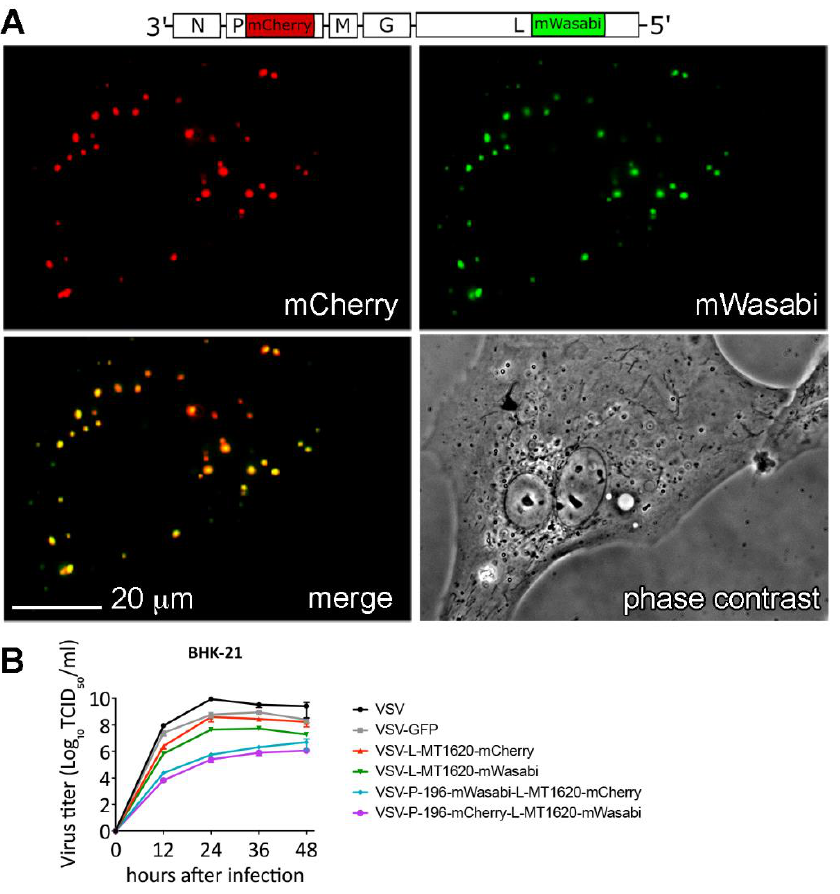
Figure 6. Attenuated double P- and L-insertion viruses display co-localizing fluorescent signals: ( A ) Assessment of putative P- and L-protein interaction in a representative micrograph of BHK-21 cells infected with VSV-P-mCherry-L-mWasabi at MOI of 10 at 10 h post infection. ( B ) Viral replication kinetics of parental VSV, VSV-GFP, VSV-L-MT1620-mCherry, VSV-L-MT1620-mWasabi, VSV-P-mWasabi-L-mCherry, and VSV-P-mCherry-L-mWasabi compared in BHK-21 at 37 °C in a multistep replication kinetics (MOI 0.1) at time points 12, 24, 36, and 48 h after infection. Titers were quantified using TCID50. Data shown as mean (SD) from two independent samples.